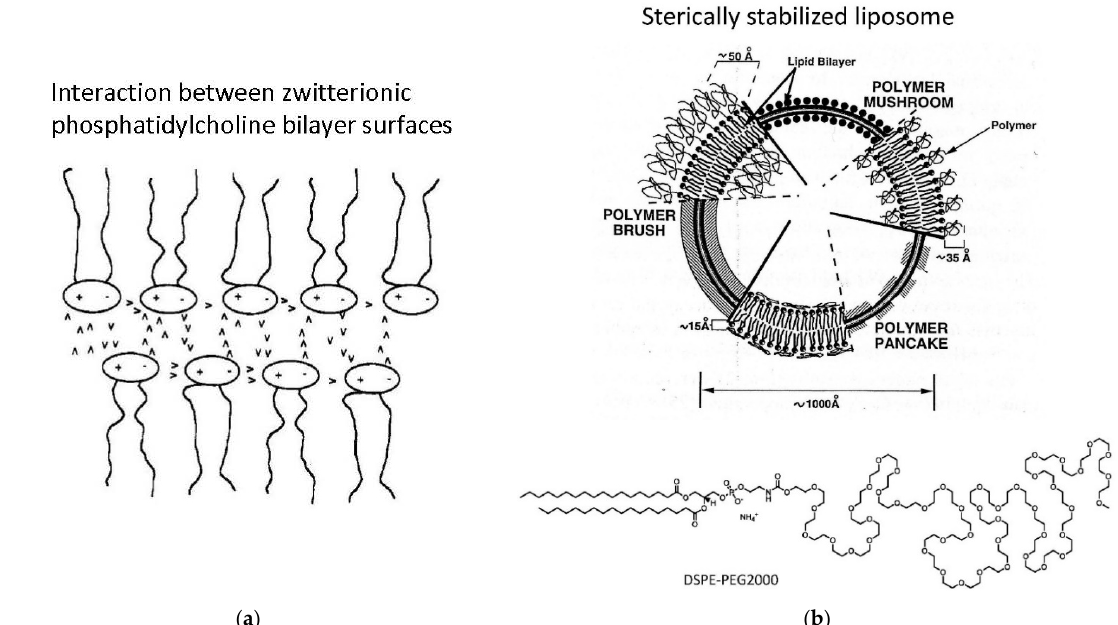
Figure 16. Possible way of improving the physical stability of lipid vesicles in vitro and in vivo by using PEGylated lipids. ( a ) Schematic illustration of the localization of water molecules on the polar surface of fluid zwitterionic PC bilayers, as sketched by Rand et al. (1988) [159], resulting in bilayer repulsions due to “hydration forces”. Each phosphoryl head group is capable of polarizing water molecules in opposite directions. For an inter-bilayer contact, a force has to be applied to remove the water molecules from the inter-bilayer space. This hydration force prevents bilayer aggregation in the L α phase and prevents fluid lipid vesicle aggregation in lipid vesicle dispersions at T > T m . Other repulsive interactions between dispersed lipid vesicles are electrostatic interactions in the case of charged vesicles and steric repulsions for vesicles containing water-soluble polymers attached to some of the polar head groups on the surface of the vesicles (“PEGylated liposomes”) [172,173]. ( b ) Top : Schematic representation of the situation on the surface of PEGylated liposomes, depicting various possible PEG chain densities (pancake, mushroom, or brush regime), from ˇCeh et al. (1997) [173]. For in vivo applications of “stealth liposomes” [172,173], the stealth effect is achieved for PEGylated liposomes in the brush regime [175]. Bottom : Chemical structure of DSPE-PEG2000 with 45 ethyleneoxide repeating units and a terminal methoxy group. Reproduced with permission from [159], American Chemical Society, 1988; and from [173], Elsevier,